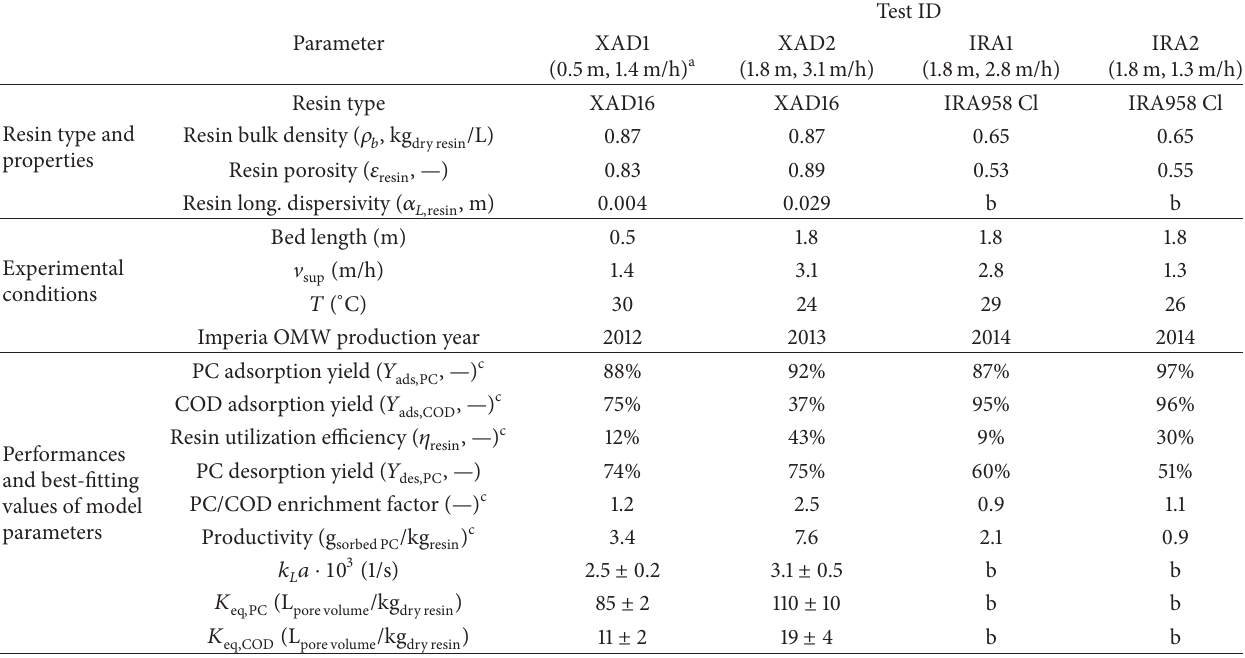
Table 3: Experimental conditions, resin and packed bed properties, and adsorption/desorption performances relative to the breakthrough